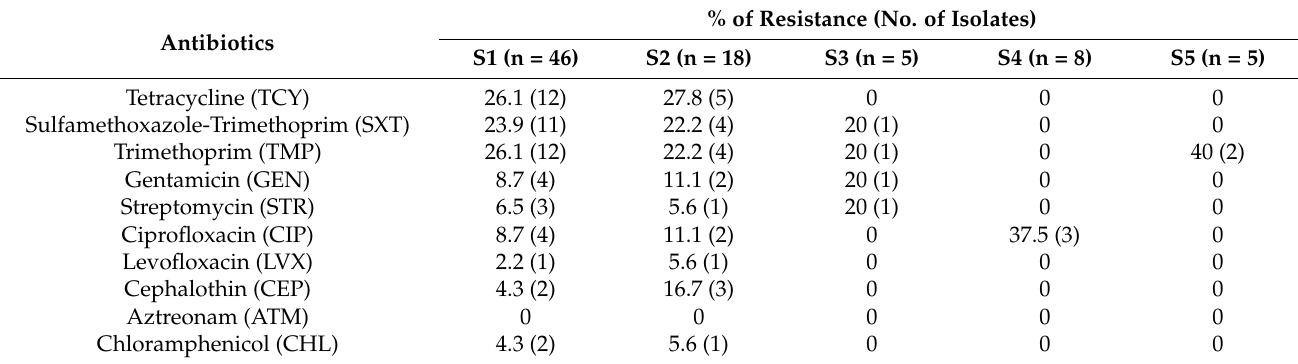
Table 1. Antibiotic susceptibility profiles of E. coli isolates from seawater and beach